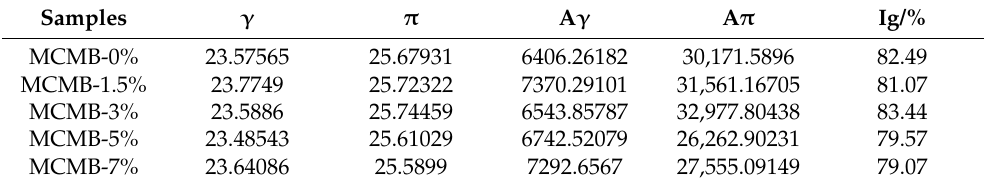
Table 3. The I g ’s of MCMBs.